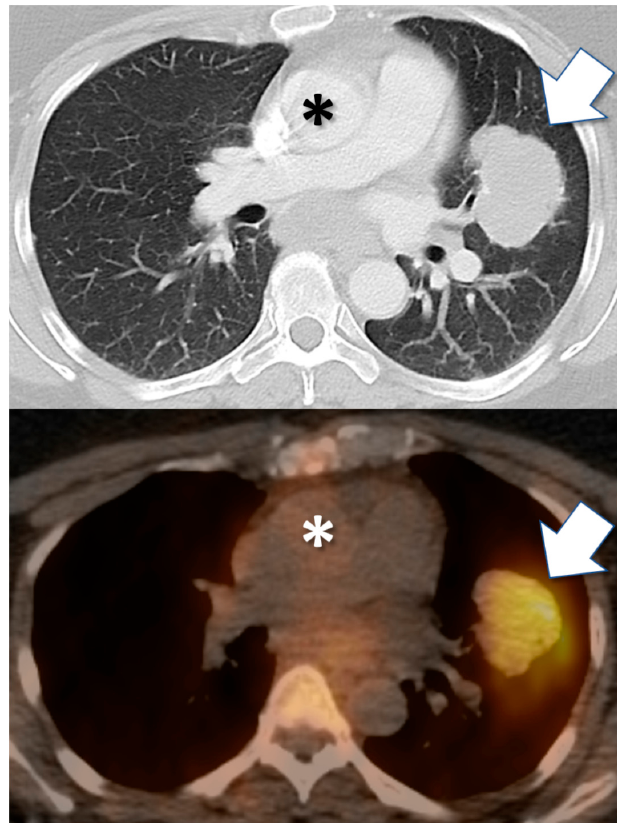
Figure 2. Drug tracer imaging detects in vivo tumor avidity for therapeutic small molecule compounds. Axial CT (top) and PET / CT fusion (bottom) images from 57-year-old female with clear cell carcinoma of Müllerian origin, including biopsied malignant pulmonary mass (arrow). PET / CT image obtained 24 h after injection with I-124 PU-H71 radiotracer, an isotopologue of the epichaperome inhibitor therapeutic compound PU-H71. PET demonstrates marked retention of drug by tumor, after drug has cleared from blood circulation (e.g., cardiac blood pool, asterisk